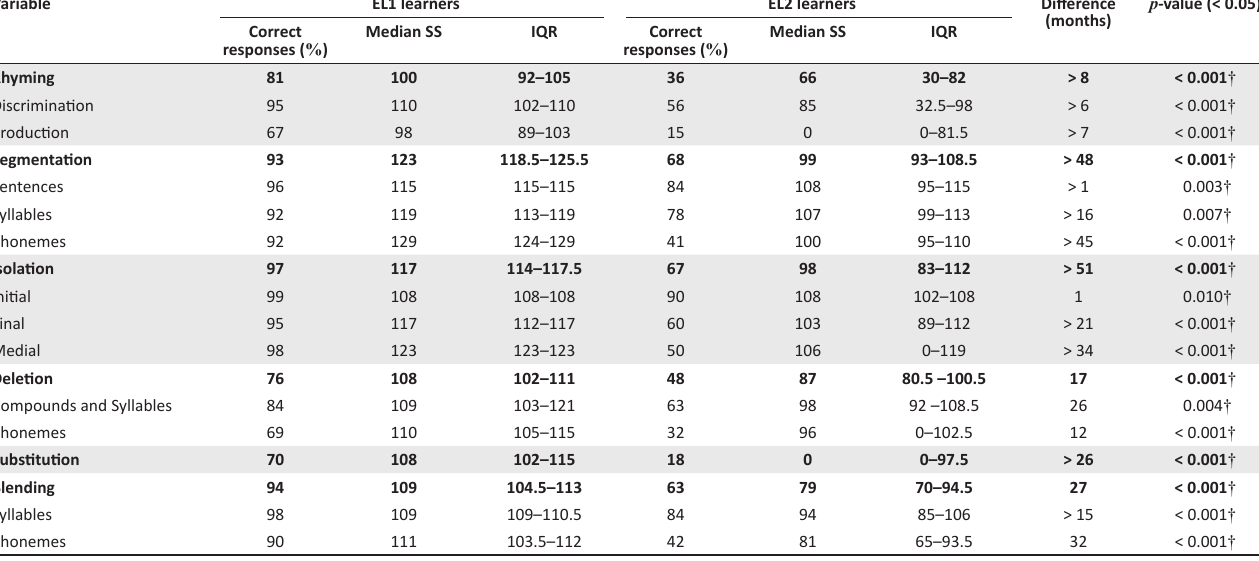
FIGURE 1: SA Eng DIN Test: Speech reception thresholds for the English first language and English second language learners. TABLE 2: Comparison of scores for English first language and English second language learners in sub-sections of the PAT- 2: Phonological Awareness section. Variable